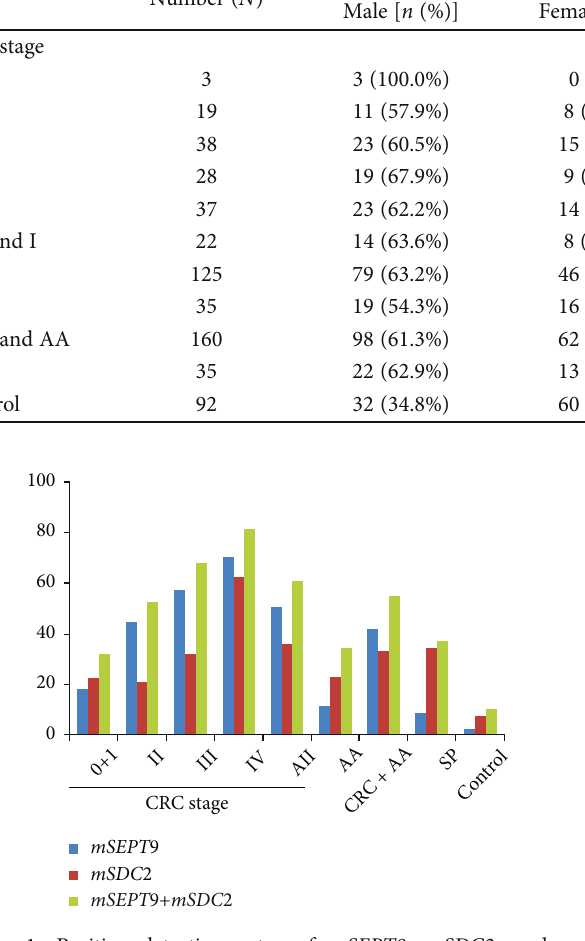
Figure 1: Positive detection rates of mSEPT9 , mSDC2 , and combined ColoDefense tests for detecting di ff erent disease